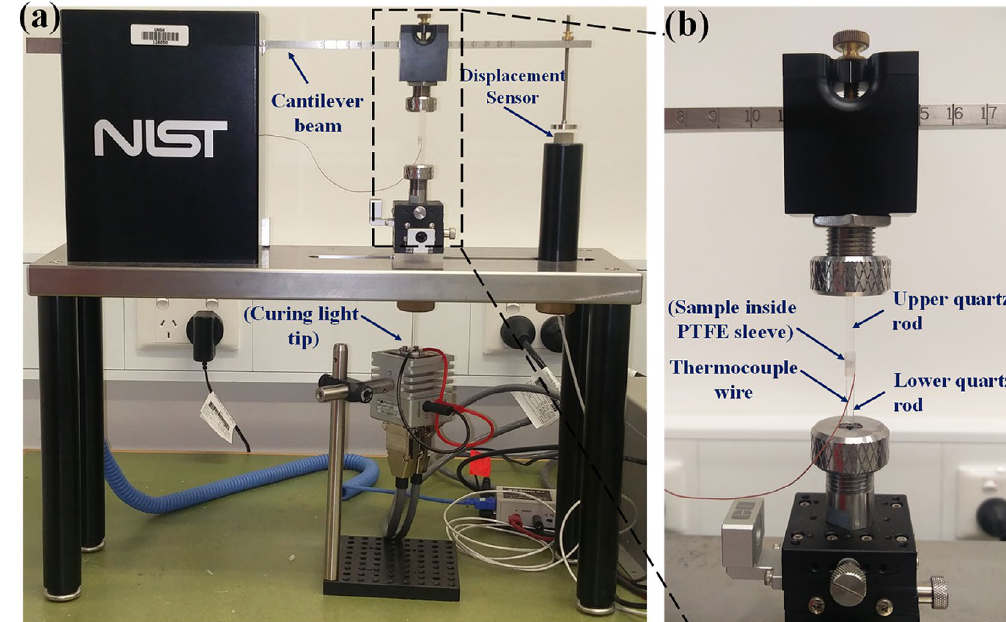
Figure 1. ( a ) Cantilever beam based NIST instrumentation for polymerisation stress and thermocouple based exotherm measurement system ( b ) Close-up view of sample mounting zone showing the sample embedded between two quartz rods and thermocouple